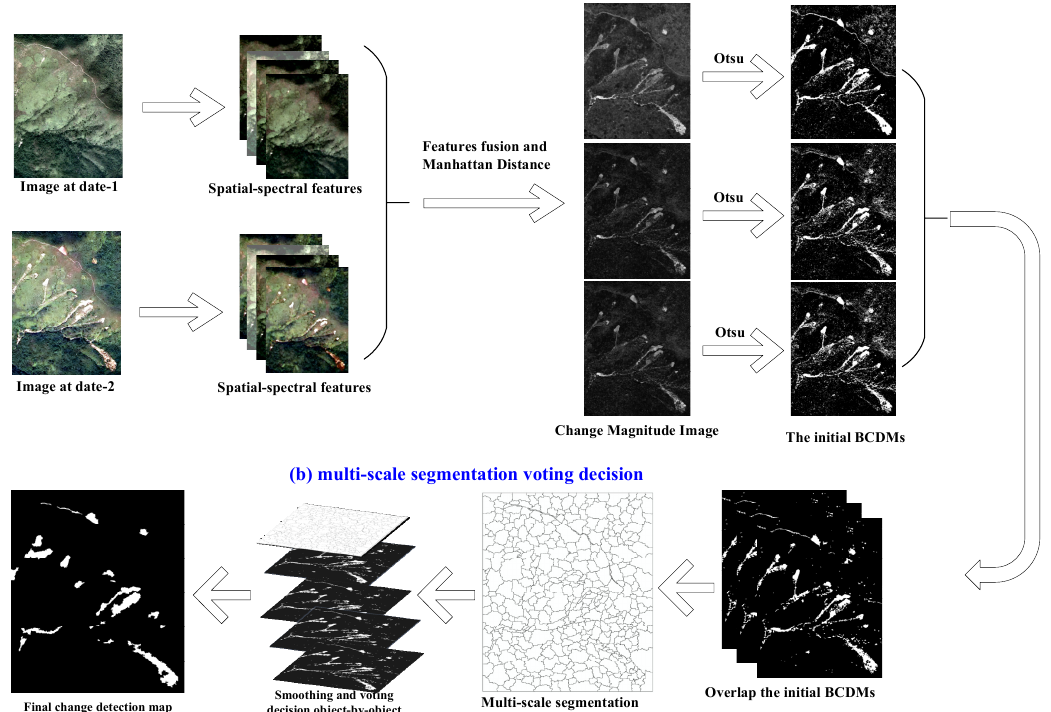
Figure 1. Flowchart of the proposed framework based on the multi-feature fusion and multi-scale segmentation voting decision.